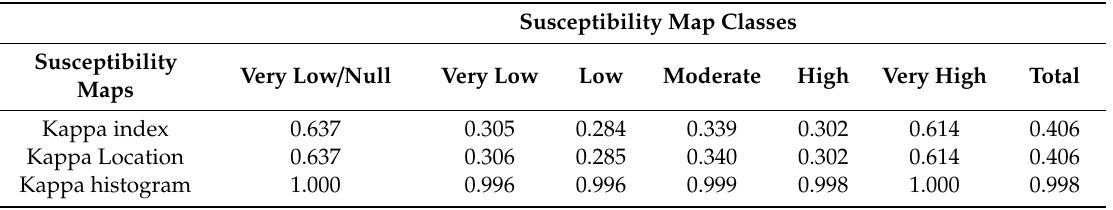
Table 3. Kappa values obtained by comparing the susceptibility Model A1 vs. Model A2.